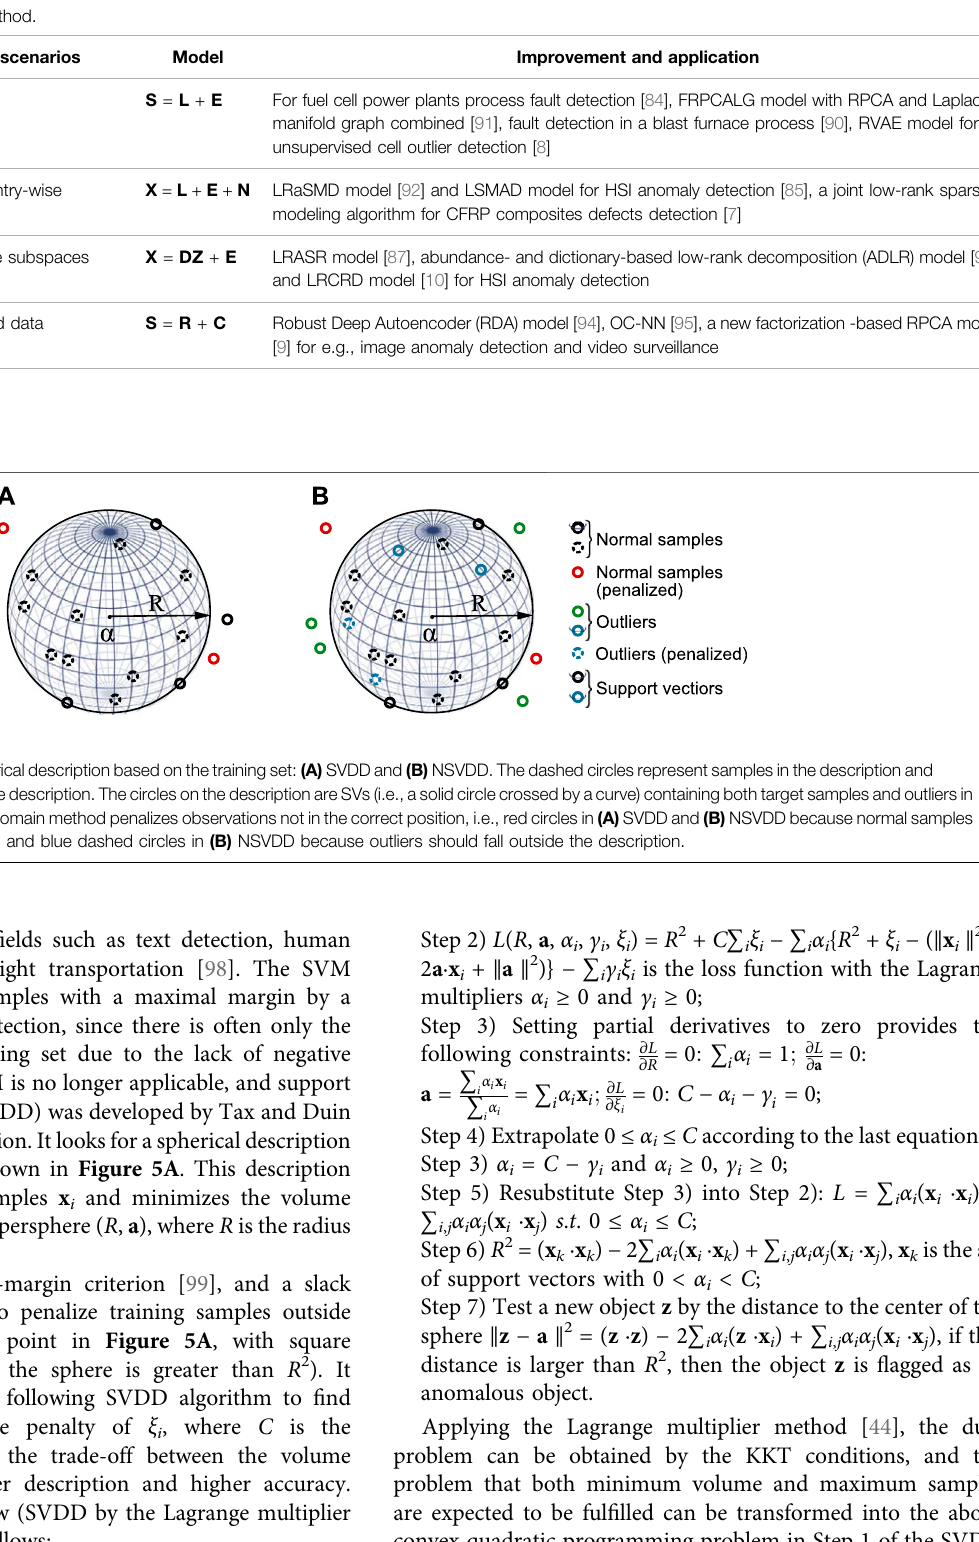
Frontiers in Physics |